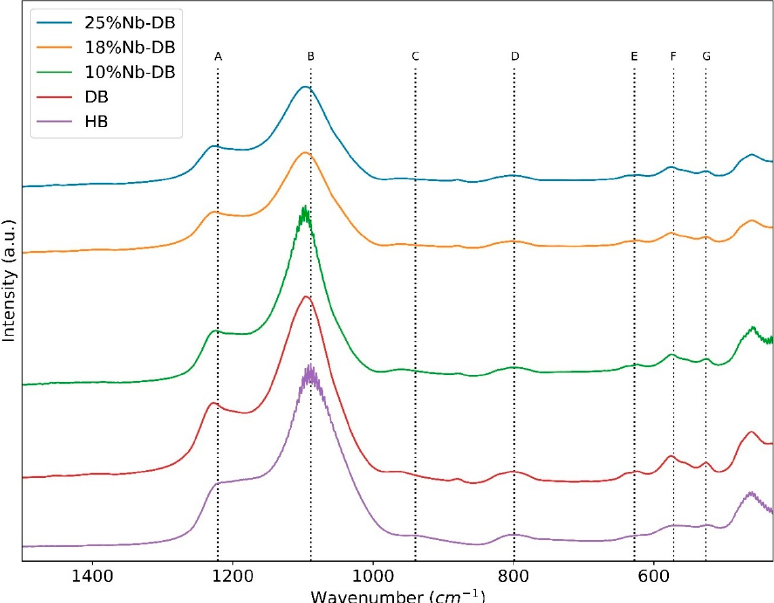
Figure 2. Fourier transform infrared spectroscopy (FTIR) spectra of the catalysts, indicating the main bands A to